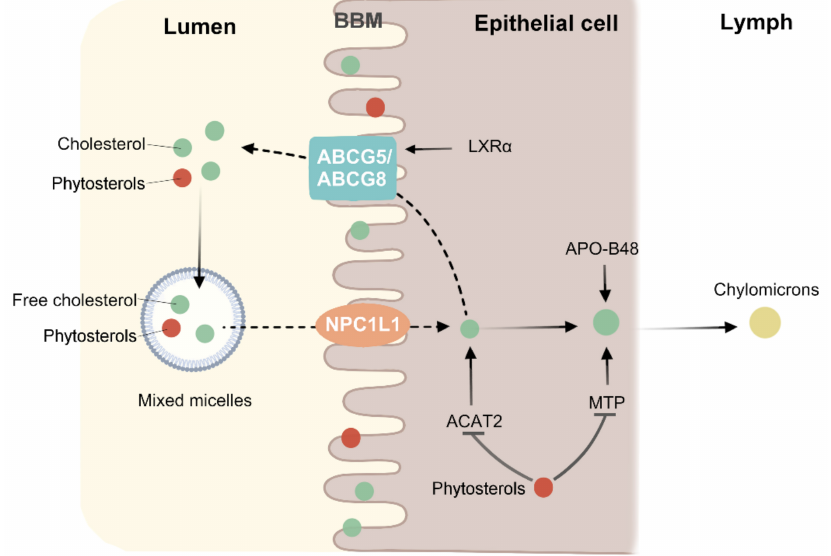
Figure 3. Phytosterols inhibit cholesterol absorption. Cholesterol and phytosterols have similar chemical structures, and thus have similar metabolic mechanisms. Apolipoprotein B48 (APO-B48) and microsomal triglyceride transfer protein (MTP) can incorporate cholesterol esters into chylomicron. ABCG5 and ABCG8 genes may be upregulated by Liver X receptor α (LXR α ) in a high cholesterol environment. Phytosterols compete with cholesterol in micelles in the intestinal lumen and brush border membrane (BBM), thereby reducing cholesterol absorption. By affecting the expression of ACAT2 and MTP, the cholesterol esterification and the amount of cholesterol entering chylomicron were